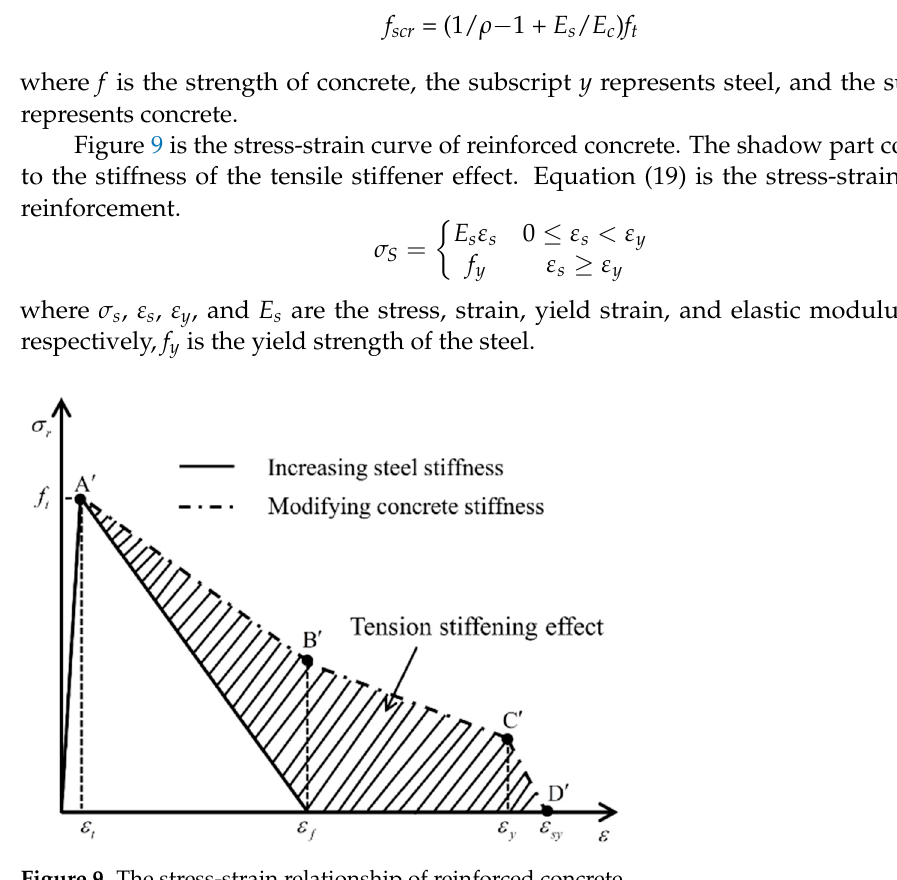
Figure 9. The stress-strain relationship of reinforced concrete.